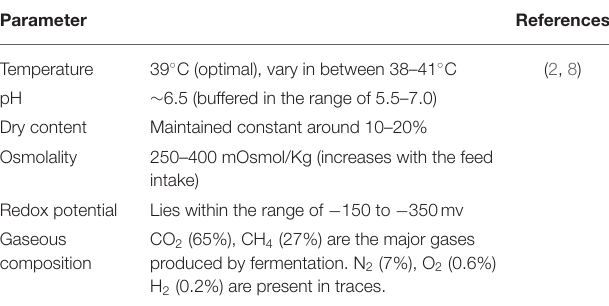
TABLE 1 | Physicochemical properties of the rumen.